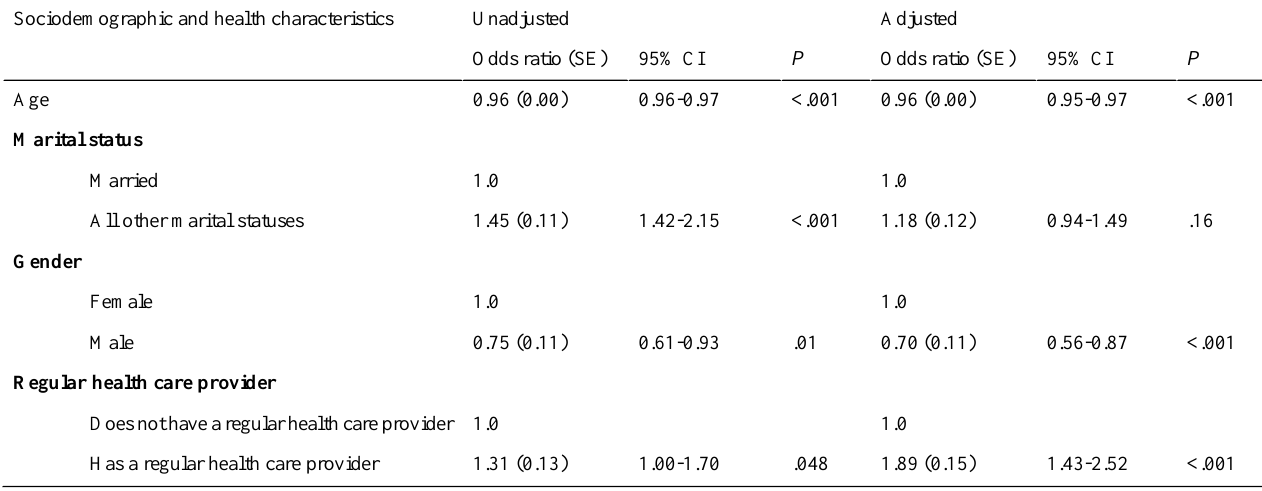
Table 4. Used social networking sites for health-related activities, such as getting information, joining a group, following friends’ health experiences, raising money, increasing awareness, and remembering or memorializing